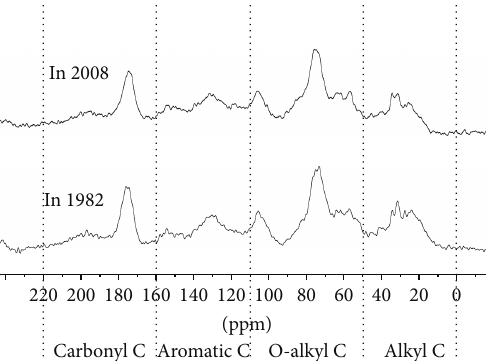
Figure 1: NMR spectra of soil total organic carbon under Carya cathayensis Sarg. forest land in different times.